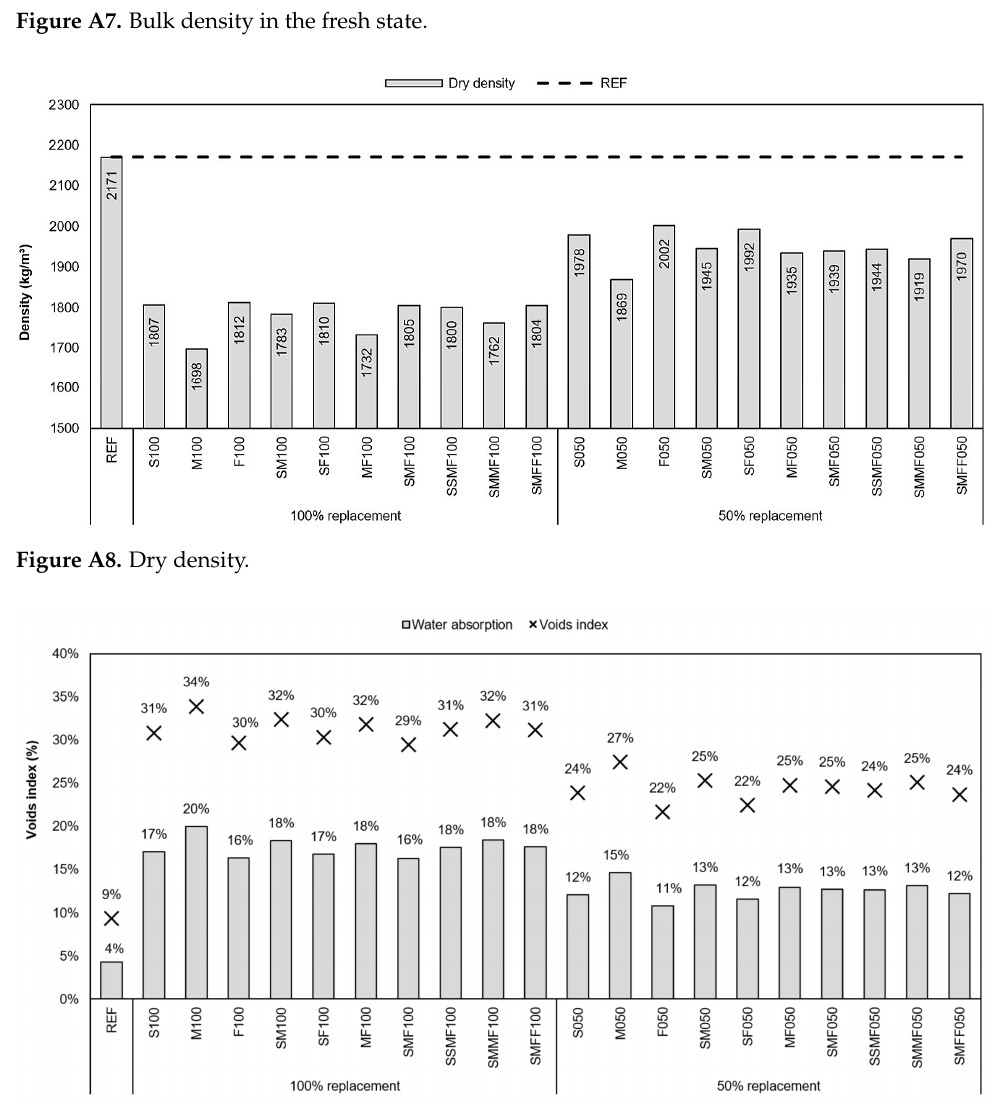
Figure A9. Water absorption and voids